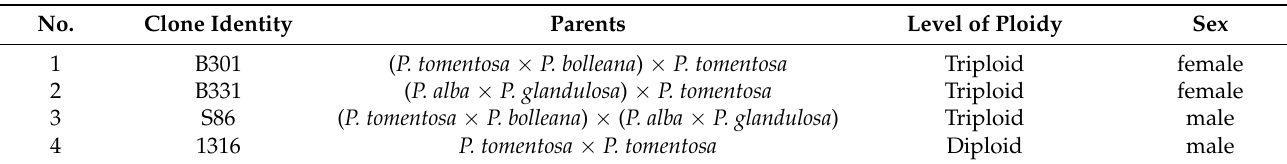
Table 1. Identity and origin of the hybrid